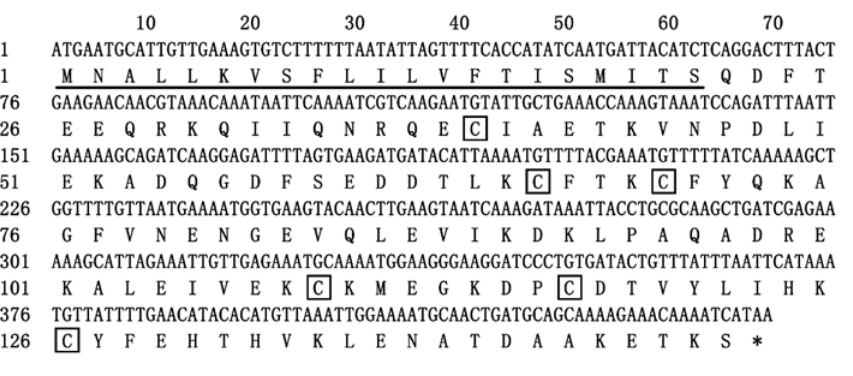
Figure 1. The cDNA and deduced amino acid sequences of EparOBP2. Underlines indicate the predicted signal peptides. The conserved Cys sites are indicated in black boxes. The asterisk indicates the translation–termination codon.